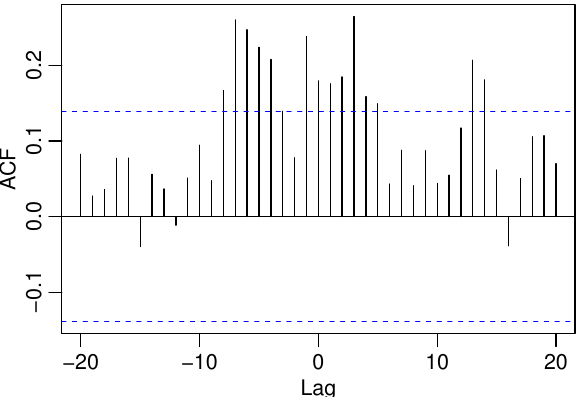
Figure 10. The CCF plot of Candies1 and Candies2 datasets.